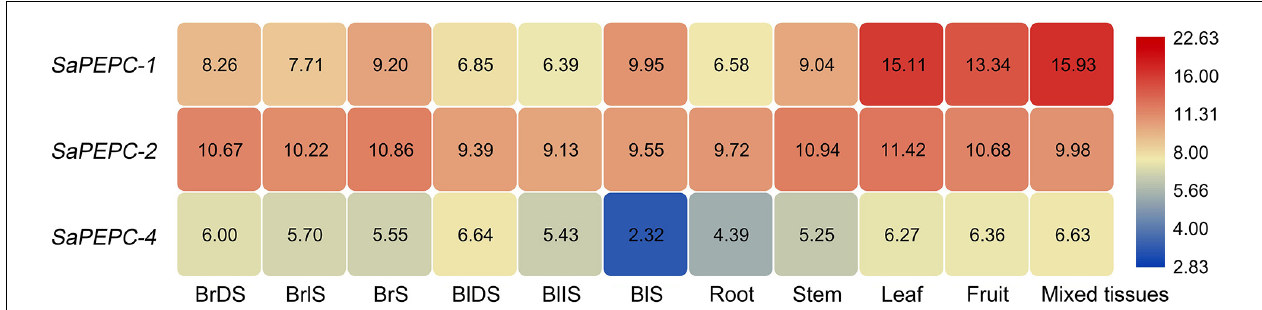
FIGURE 5 | RNA sequencing (RNA-Seq) expression analysis of the three SaPEPC genes obtained from the public transcriptomic database of S. aralocaspica . BrDS, brown dry seed; BrIS, brown imbibed seed (imbibition for 1 h); BrS, seedling germinated from brown seed (imbibition for 24 h); BlDS, black dry seed; BlIS, black imbibed seed (imbibition for 24 h); BlS, seedling germinated from black seed (germination for 10 days). The fragments per kilobase of exon per million mapped reads (FPKM) values from the RNA-Seq data were log 2